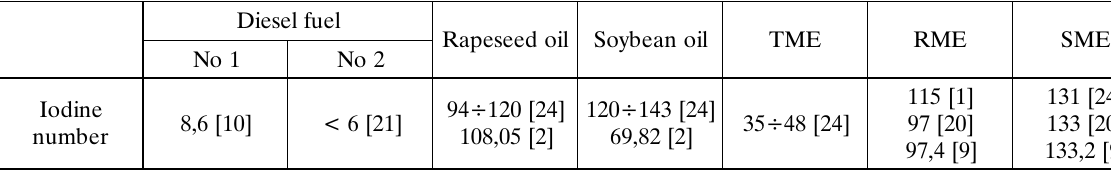
leufleseiD liodeesepaR